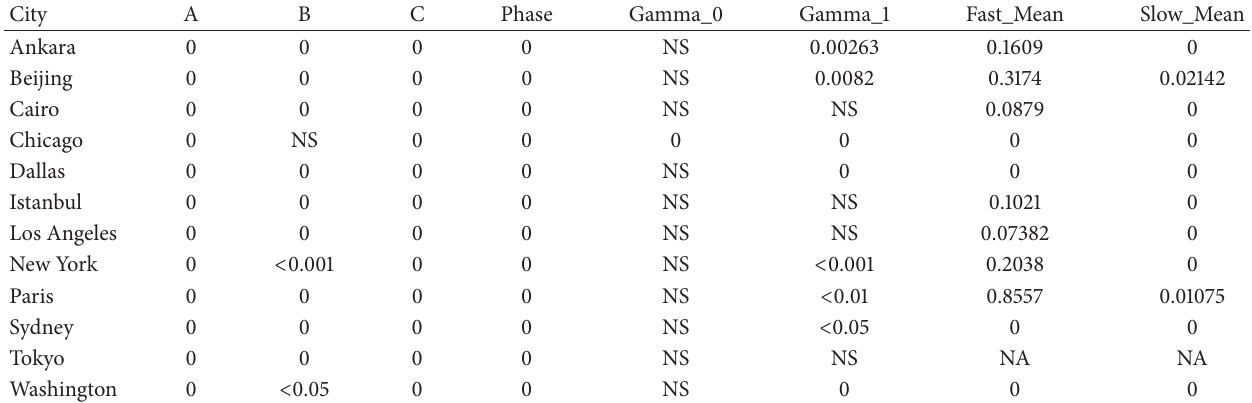
Table 5: 𝑃 values of parameters for HDD calculations.